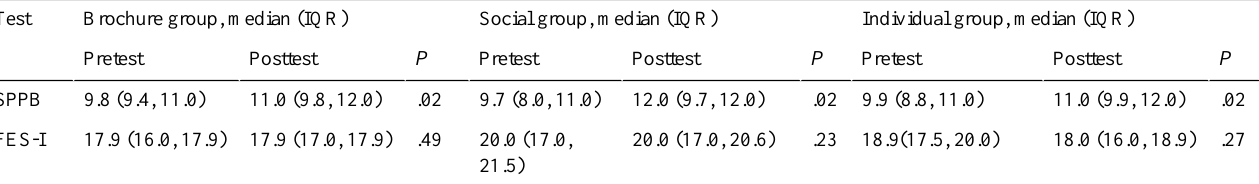
Table 5. Physical performance and fear of falling during the pretest and the posttest and significance of within-group differences pre-post calculated with Wilcoxon signed rank